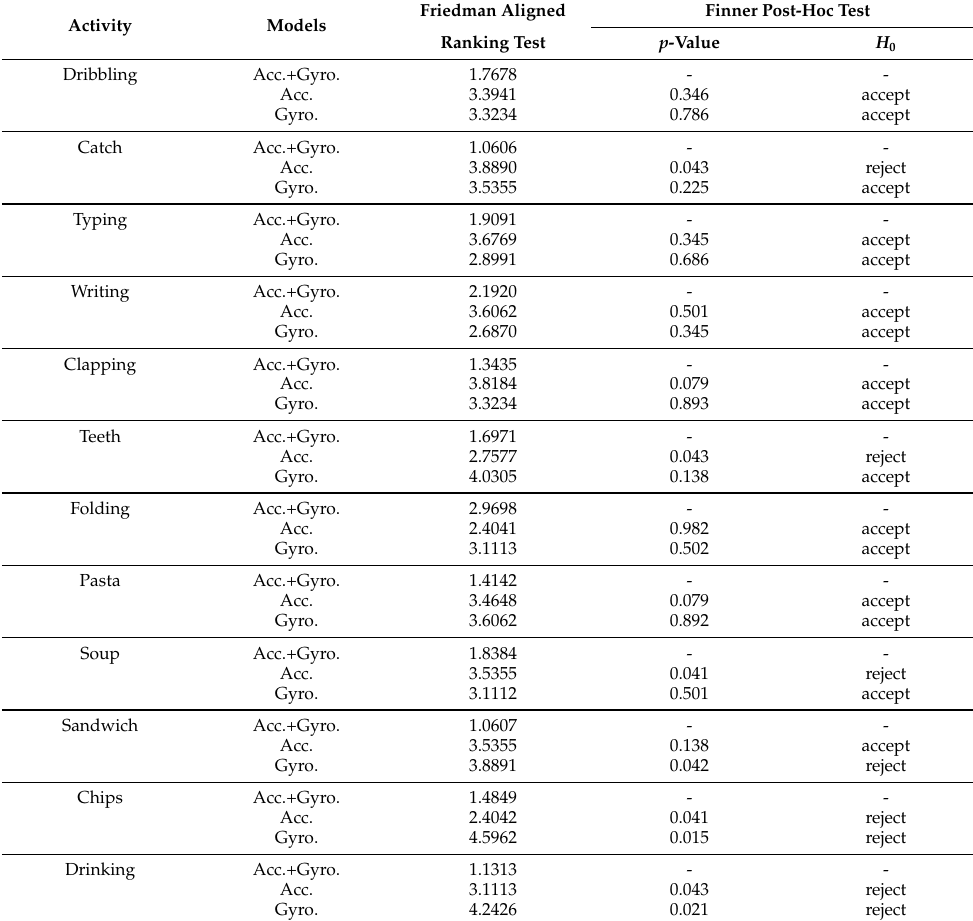
Table 11. Friedman aligned ranking test and Finner post-hoc test based on the accuracy metrics of the 1D-ResNet-SE model using different sensor data on the WISDM-HARB